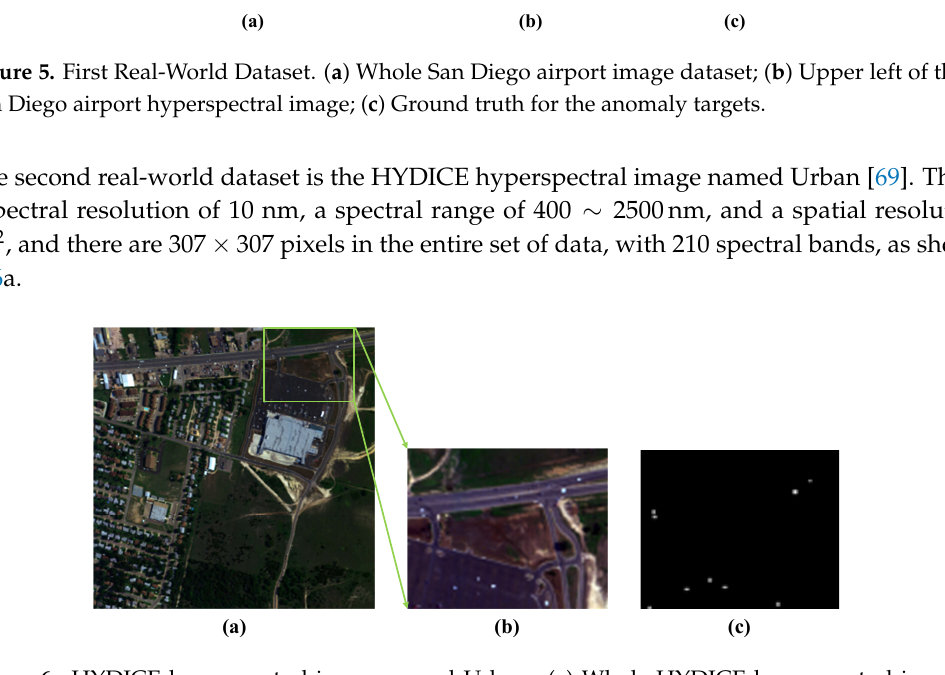
Figure 6. HYDICE hyperspectral image named Urban. ( a ) Whole HYDICE hyperspectral image; ( b ) Upper left of the scene; ( c ) Ground truth for the anomaly